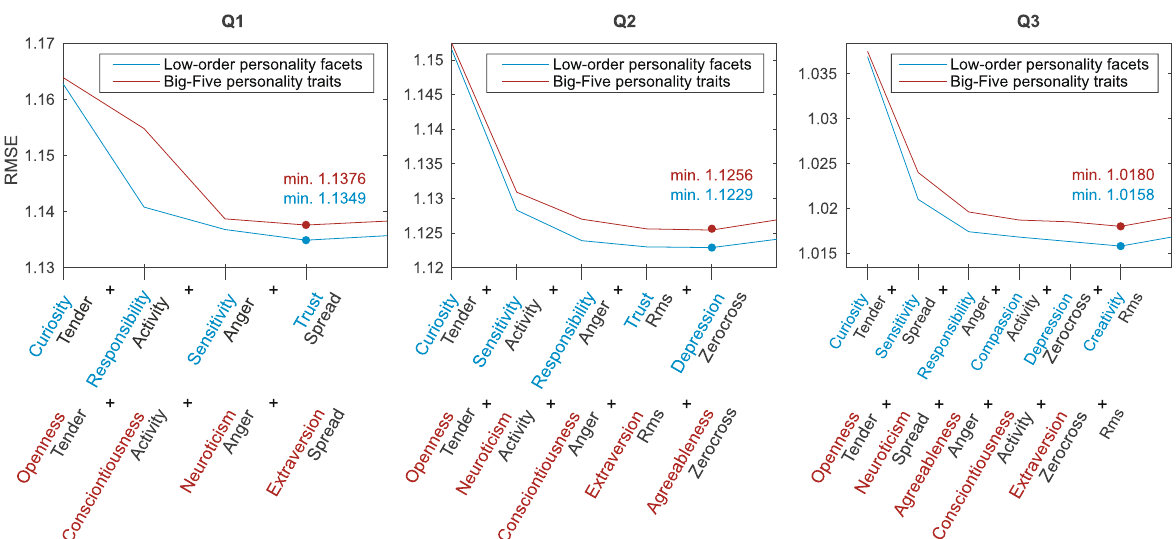
Fig. 7 The recommendation quality when gradually adding consecutive the best pairs to the previous ones. They were selected in two ways: only the best results belonging to the low-level personality facets (blue colors) and only the best results belonging to the Big Five personality domains (red color). This gradual improvement method revealed the moment (the subset of personality domains and audio features), marked by dots on each graph, after which the errors started to